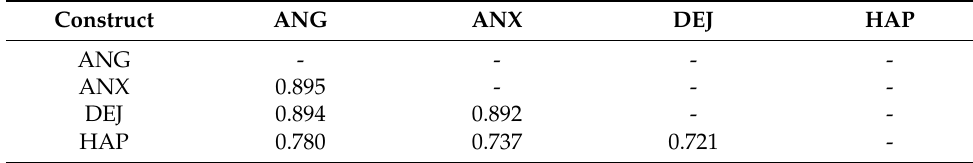
Table 7. Discriminant validity (HTMT